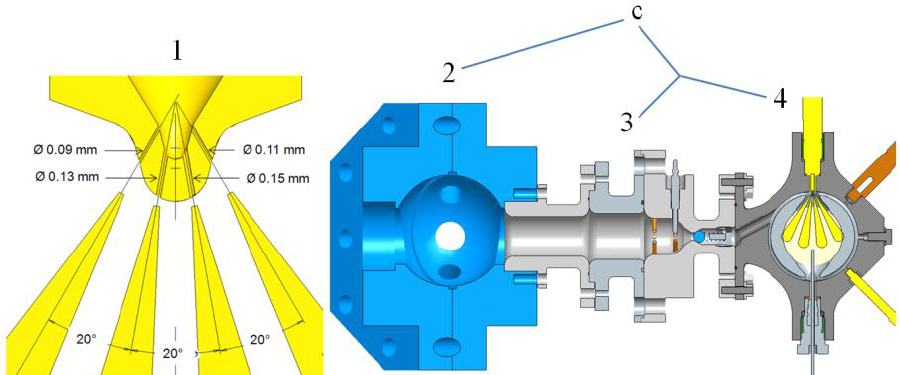
Figure 13. The swirl chamber assembly obtained by the combination of the pilot ignition optical